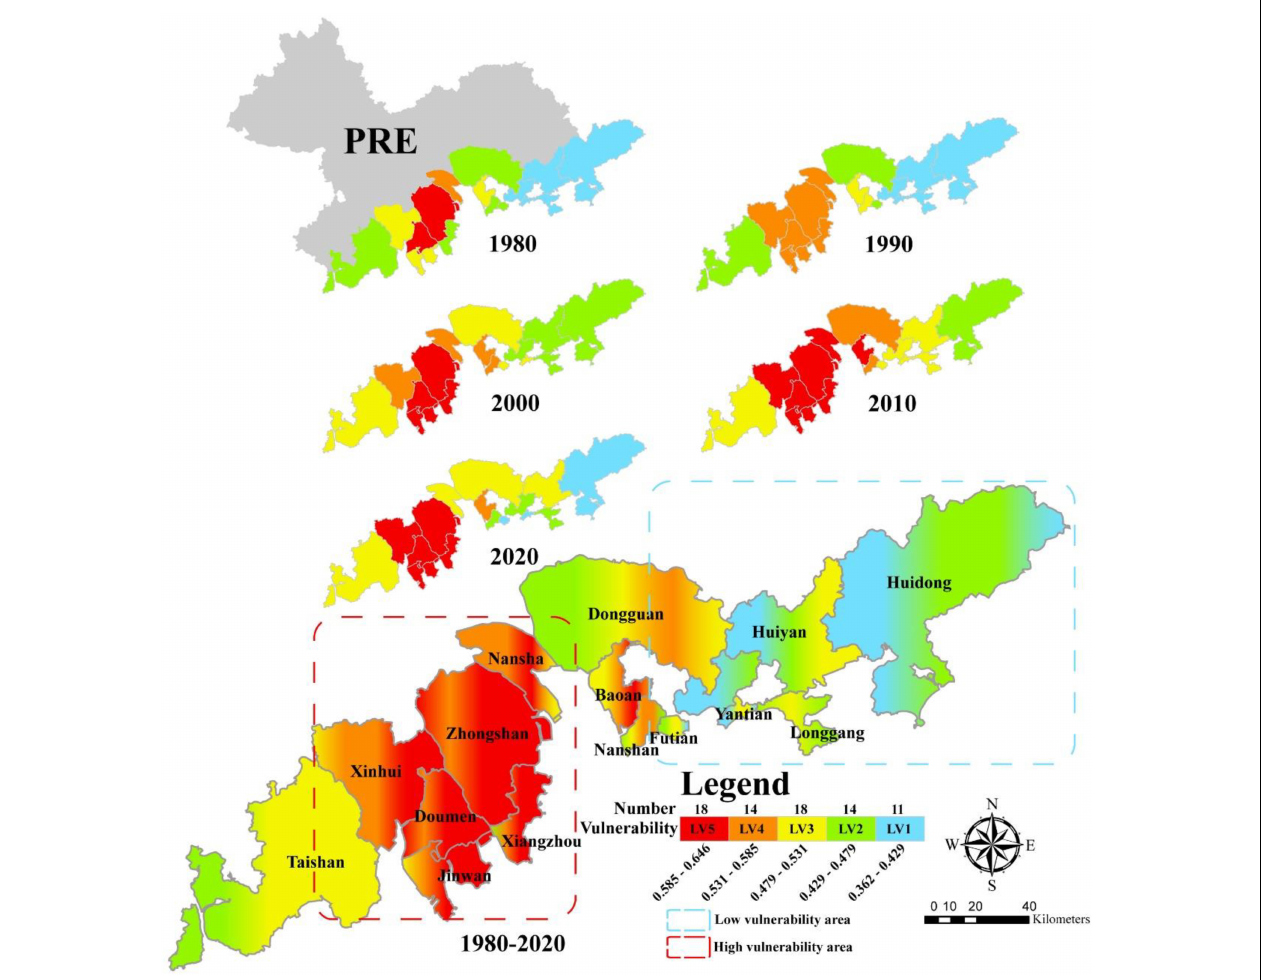
FIGURE 3 | The classification map of coastal erosion vulnerability in each era and the distributions of low-vulnerability and high-vulnerability areas in 15 counties and regions of the study area. Different colors in the color chart represent different vulnerability levels. From left to right, the colors represent high vulnerability (a total of 18 evaluation units in this interval), moderately high vulnerability (14), medium vulnerability (18), moderately low vulnerability (14) and low vulnerability (11). Finally, the evaluation unit is filled with gradient color to reflect the change of their vulnerability level from 1980 to